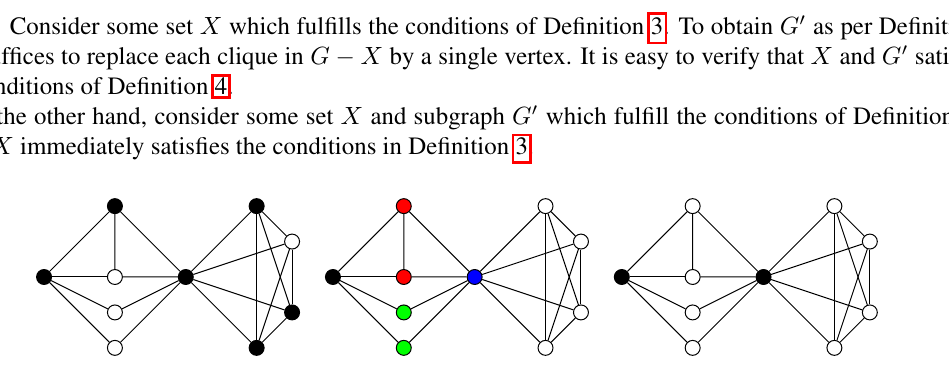
Fig. 1: From left to right: a minimum-size vertex cover (size 6 – depicted in black ), the neighborhood diversity (size 5 – each neighborhood-type with a different color ) and a minimum-size twin-cover (size 2 – depicted in black ) of an example